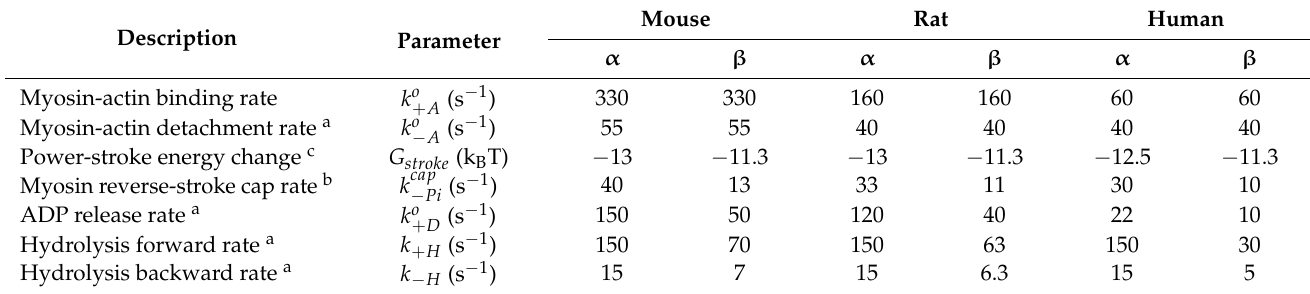
Table 2. Variable crossbridge cycle model parameters for different species and myosin